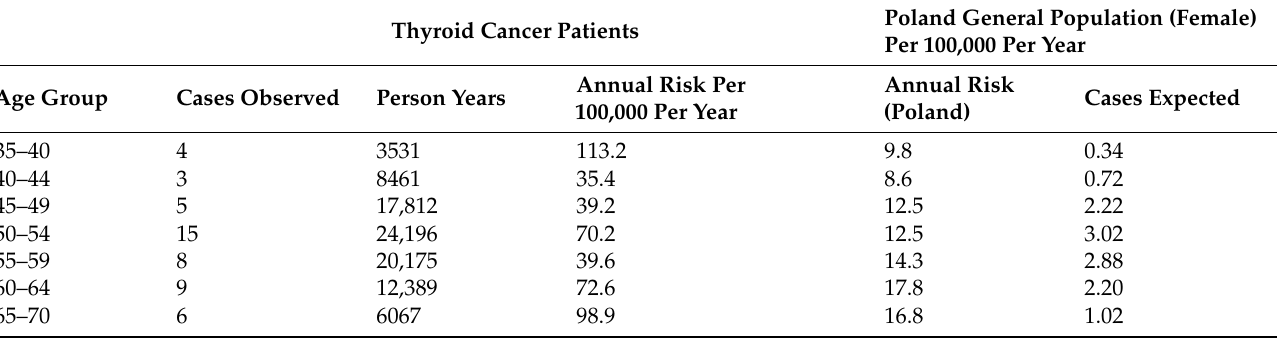
Table 2. Annual rates of thyroid cancer in the cohort.